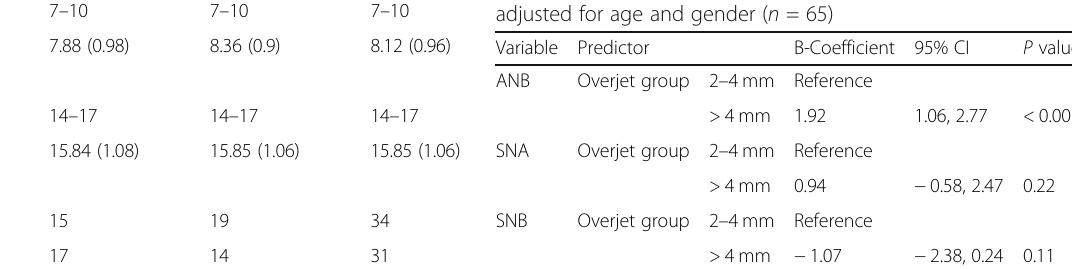
Table 4 Changes in mandibular and maxillary position